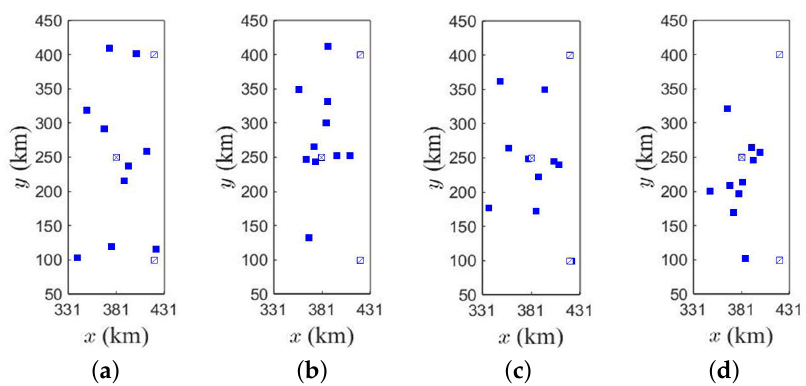
Figure 9. Optimal deployment of defense stations against pincer formation, based on ( a ) ζ 1 ; ( b ) ζ 2 ; ( c ) ζ 3 ; ( d ) ζ 4 , square with cross: major post, square with slash: minor post, blue square: defense